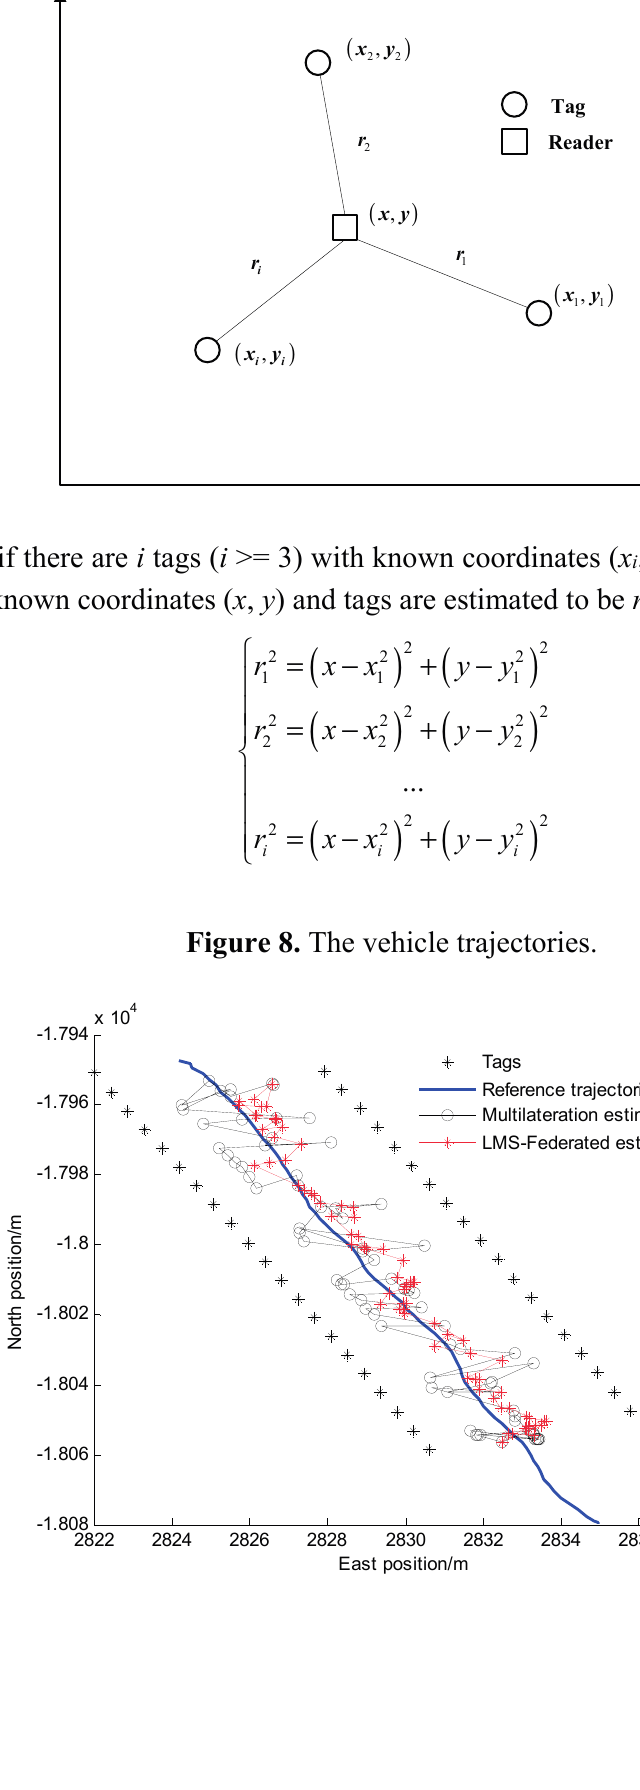
Figure 7. Schematic of the multilateration method.